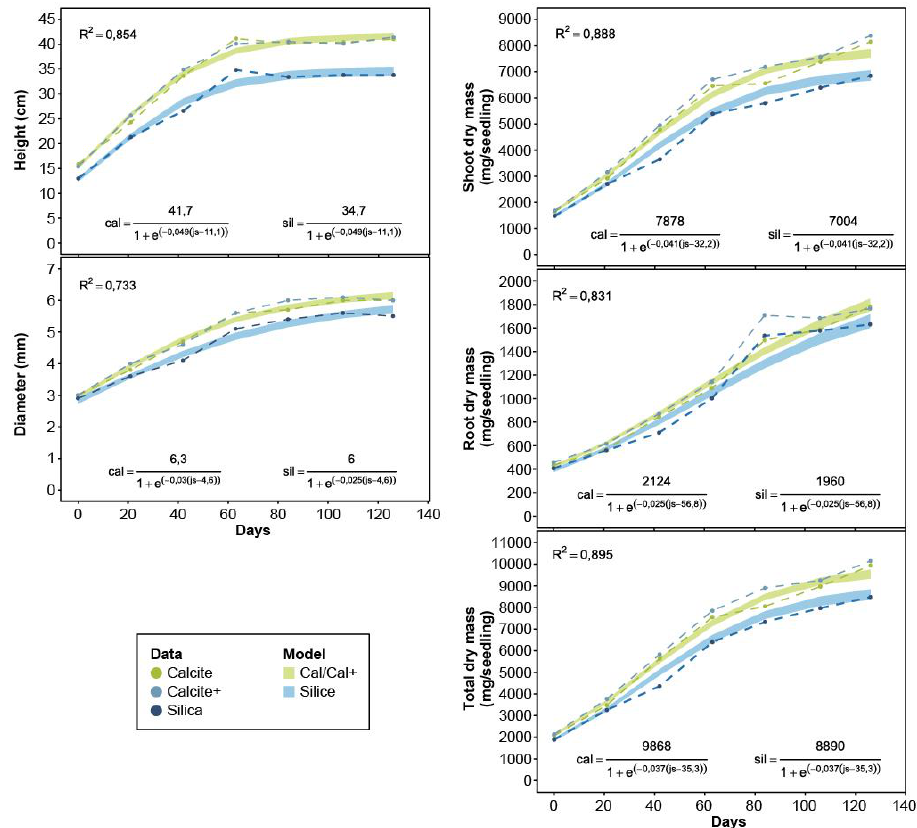
Figure 4. Evolution of the means and logistic models adjusted for each of the growth variables of white spruce seedlings (2 + 0), depending on the treatments (silica, calcite and calcite+). The width of each band corresponds to the 95% confidence interval. As the parameters of the calcite and calcite treatments did not differ significantly from each other, a single logistic model was generated by combining the data from these two treatments. The models were adjusted using all the data (n = 525 seedlings/treatment for height and diameter, and n = 105 composite samples of 5 plants/treatment for shoot, roots and total dry masses).